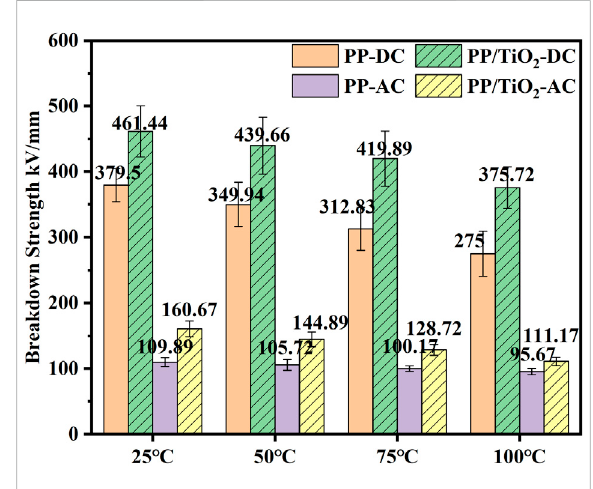
FIGURE 5 Experimental setup for the TSC.